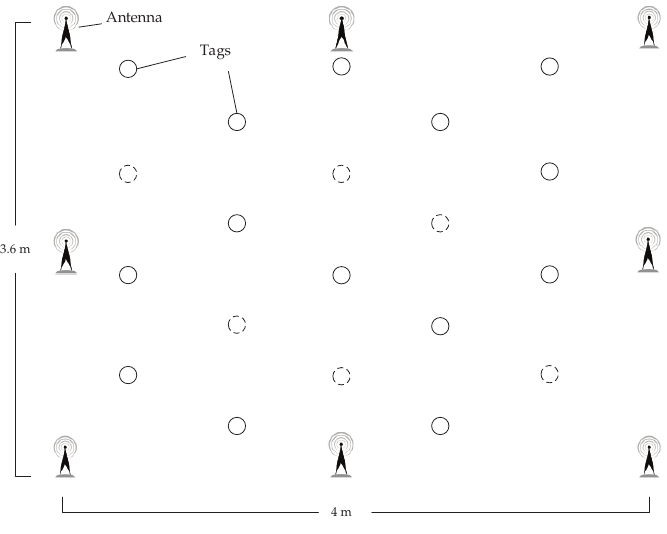
Figure 9. Realistic Experiment